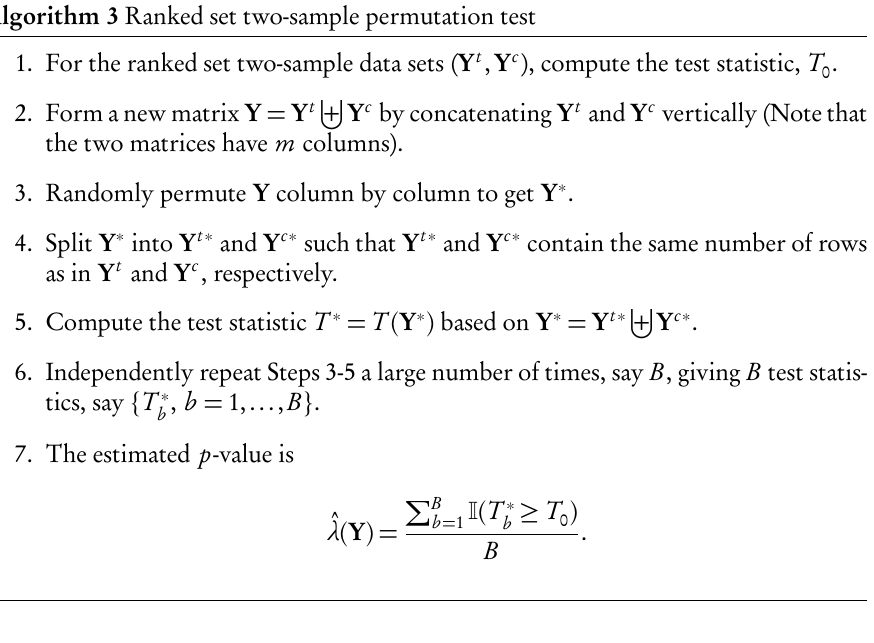
Algorithm 3 Ranked set two-sample permutation